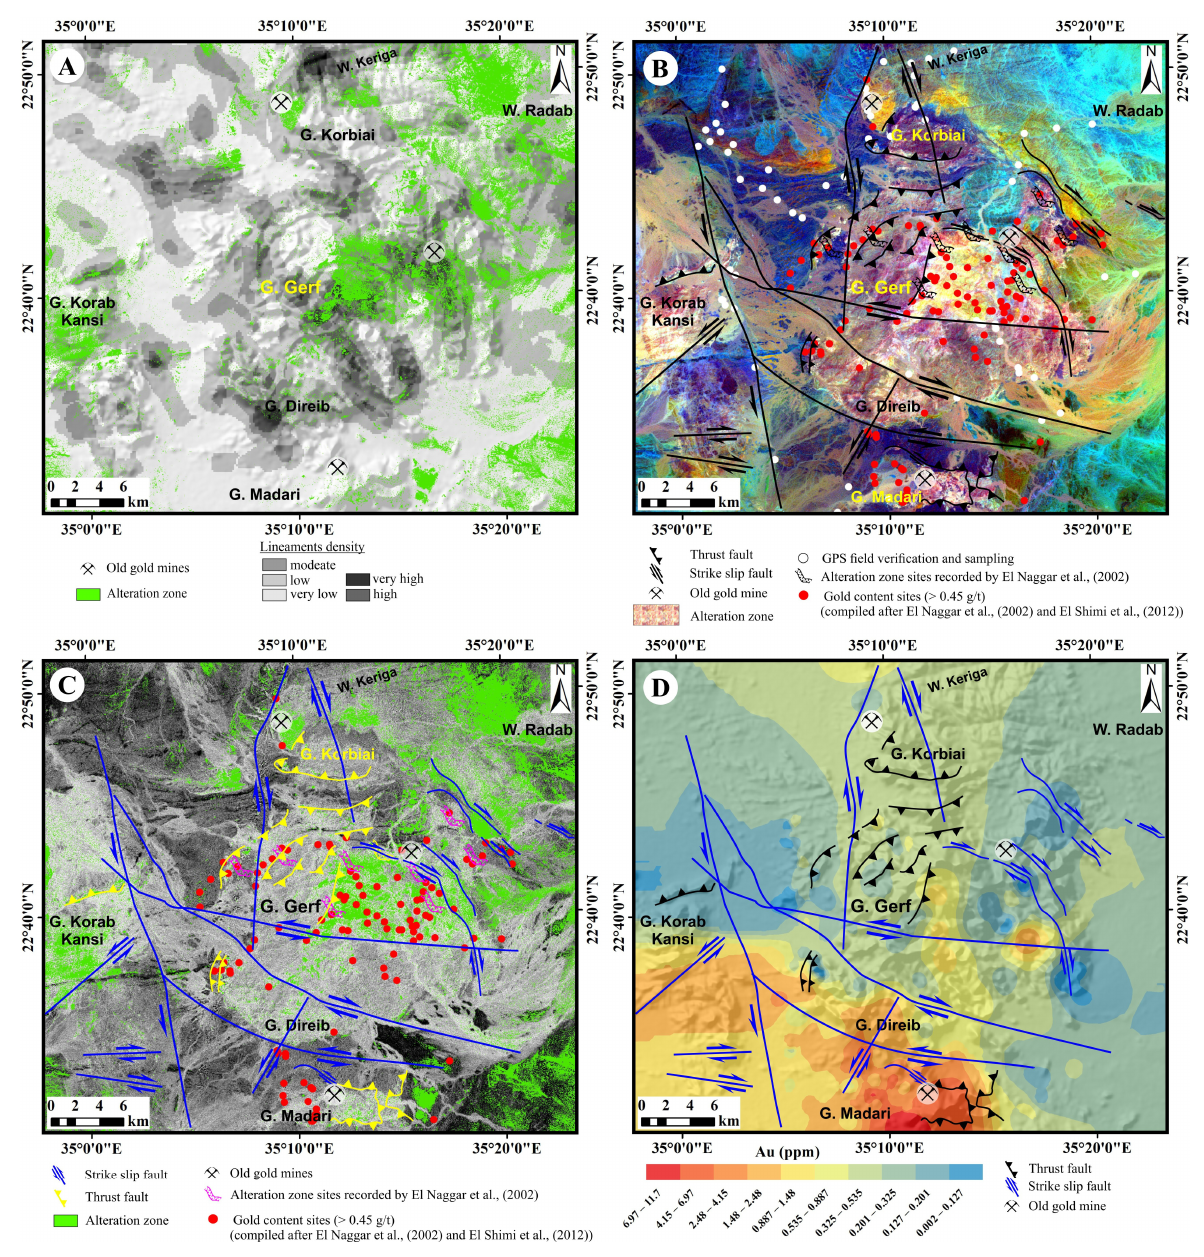
Figure 19. ( A ) The alteration zones in relation to the lineaments density maps, ( B ) Fused image of KLI, ALI, and CLI to locate the alteration zone in whitish yellow color, ( C ) The spatial distribution of the alteration zone in relation to the major structural elements, ( D ) The gold content distribution in the study area based on the data after [77,78].